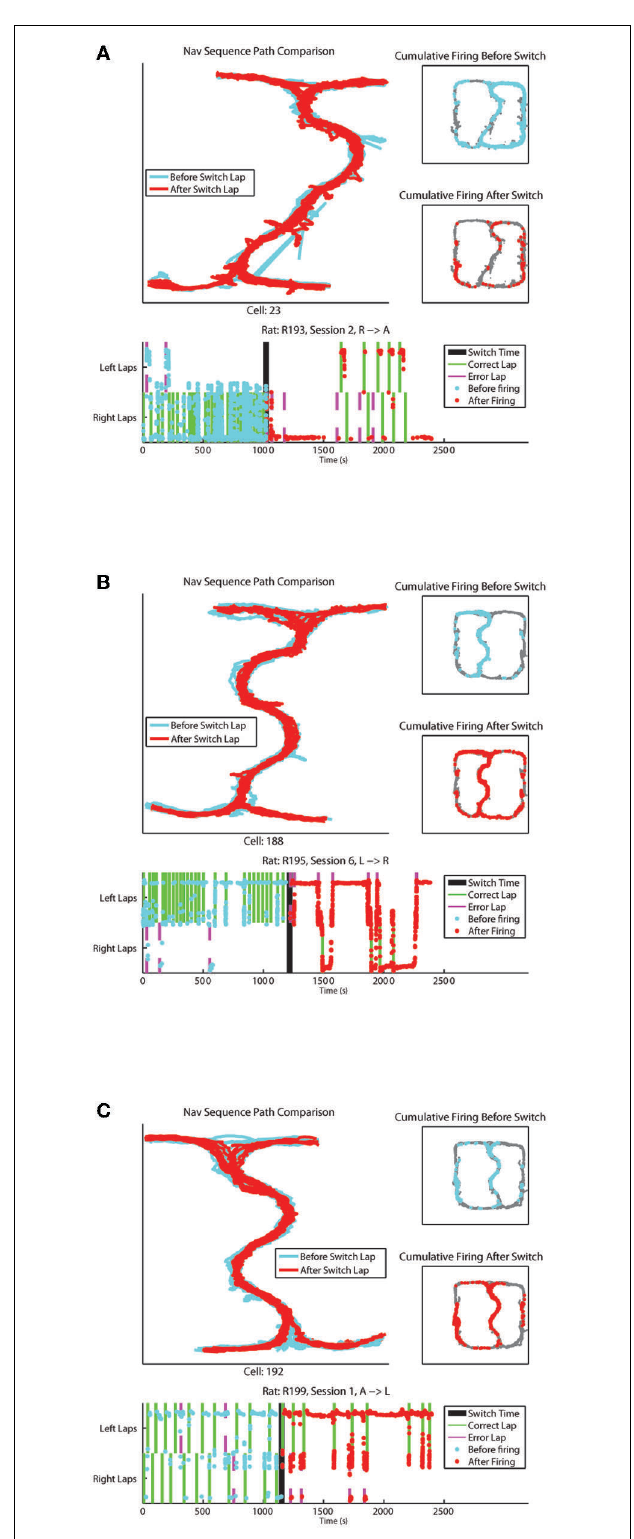
FIGURE 6 | (A–C) Represent individual cell firing examples over one session for cells displaying differential before vs. after the switch firing rates. Top left panel compares the animal’s path through the Navigation Sequence